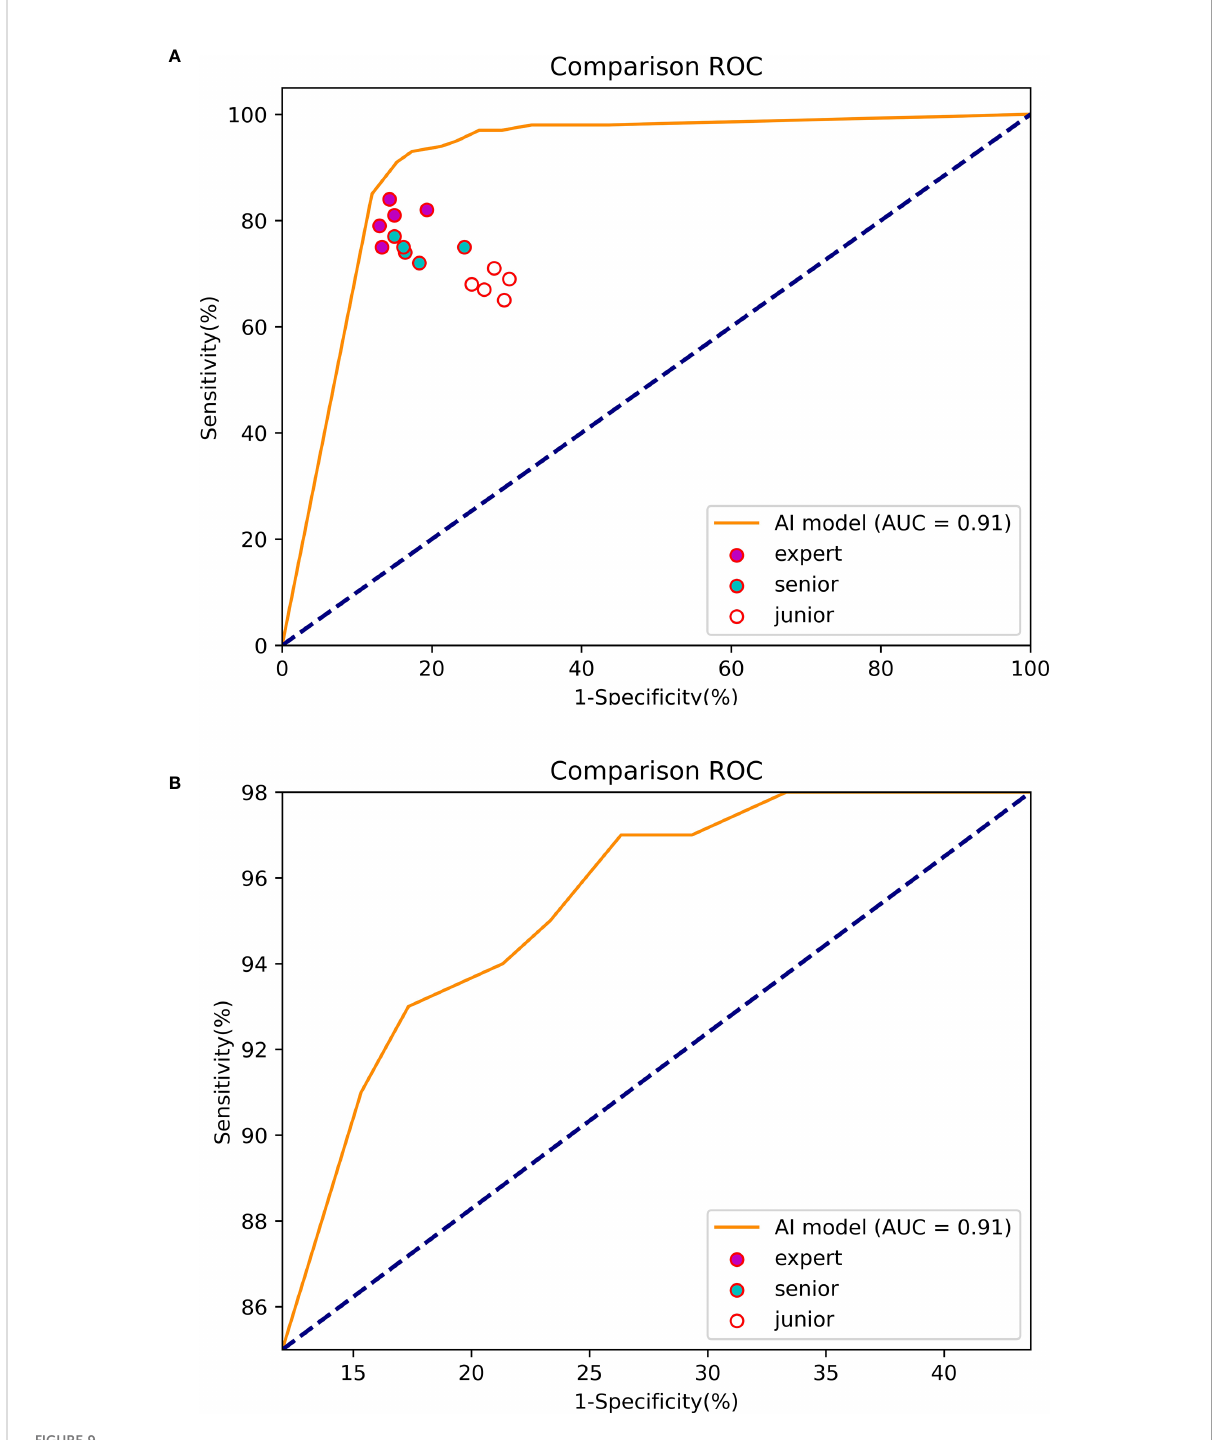
FIGURE 9 The ROC curve of the experiment between the Mask R-CNN system and Endoscopists. (A) The global ROC curve of the controlled experiment. (B) The regional ROC curve of the controlled